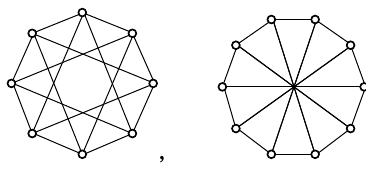
Figure 6: The bipartite circulant graphs C 8 (1, 3) ∼ = K 4,4 and C 10 (1,